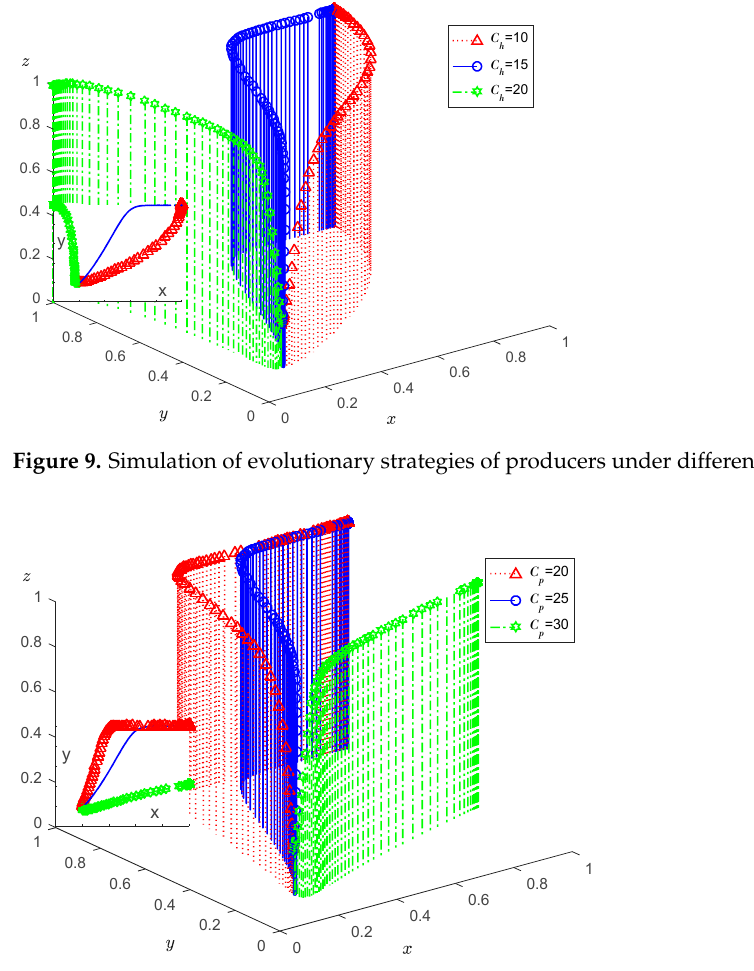
Figure 10. Simulation of evolutionary strategies of processors under different traceability costs.